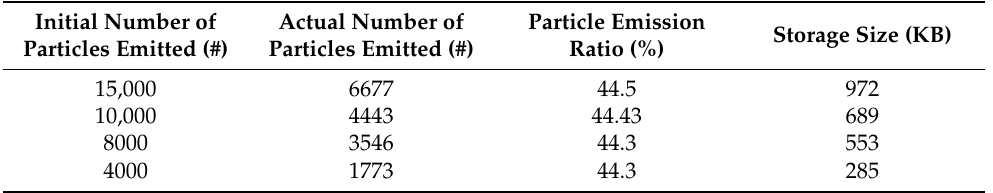
Table 3. Comparison of number of leaf particles and storage size.